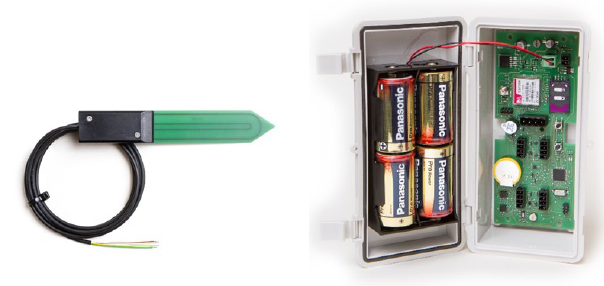
Figure 3. Picture of the soil moisture sensors SMT100 and the data logger TrueLog100 from Truebner